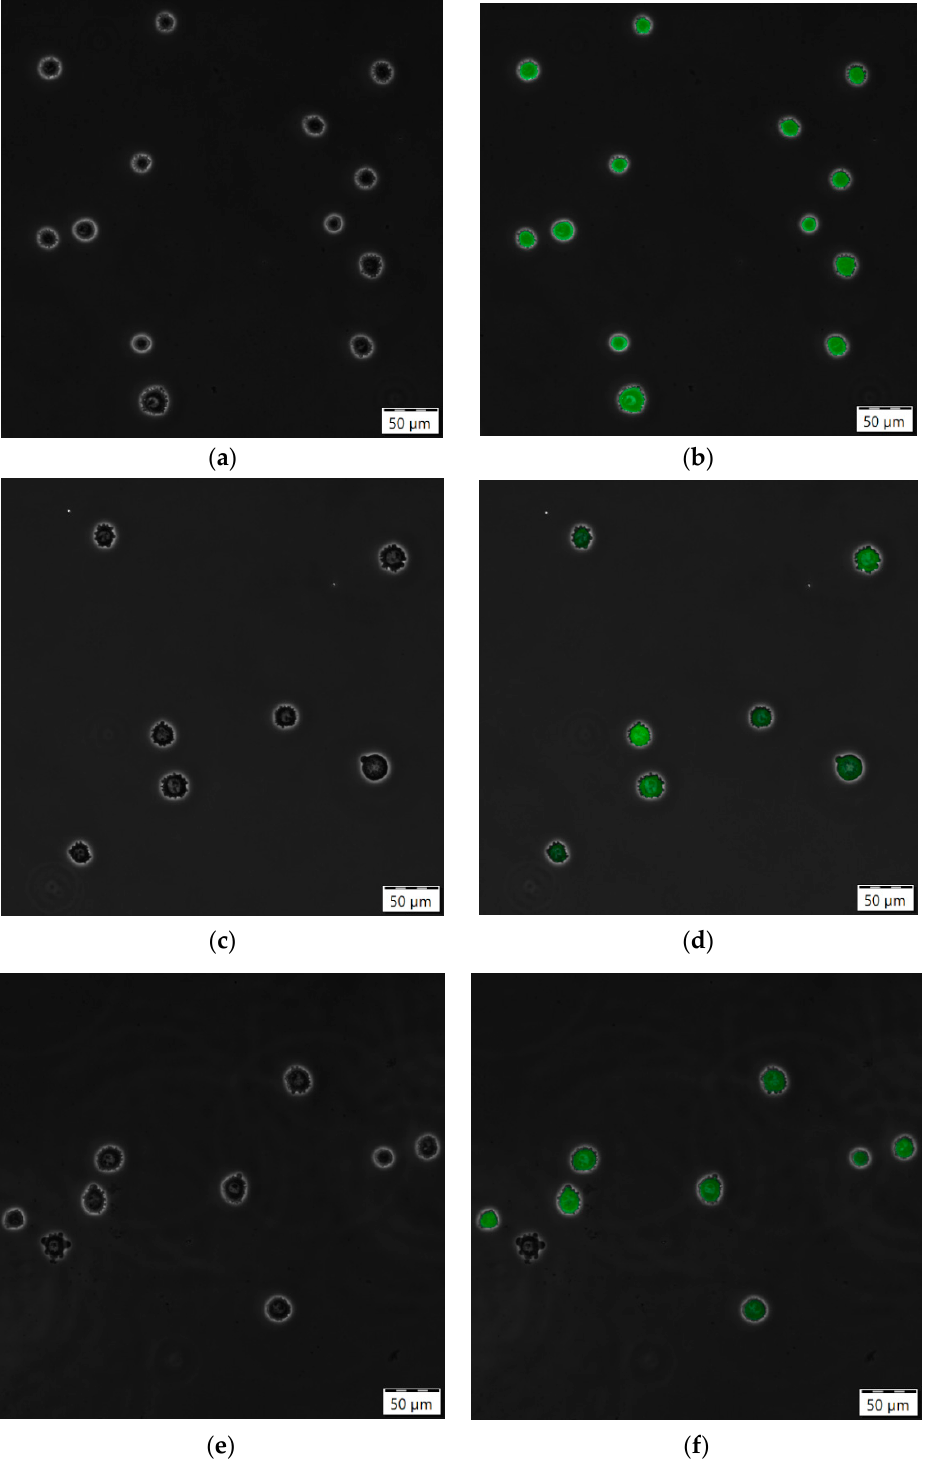
Figure A5. Microscopic images (200×) of ( a , b ) cells after one-week standard inoculum production, ( c , d ) cells from a cryovial containing 15 × 10 6 cells mL − 1 , 1 d after thawing, and ( e , f ) cells from a cryovial containing 260 × 10 6 cells mL − 1 , 1 d after thawing. ( a , c , e ) phase contrast images, ( b , d , f ) phase contrast and fluorescence images (fluorescein diacetate staining for cells with intact cell membrane).